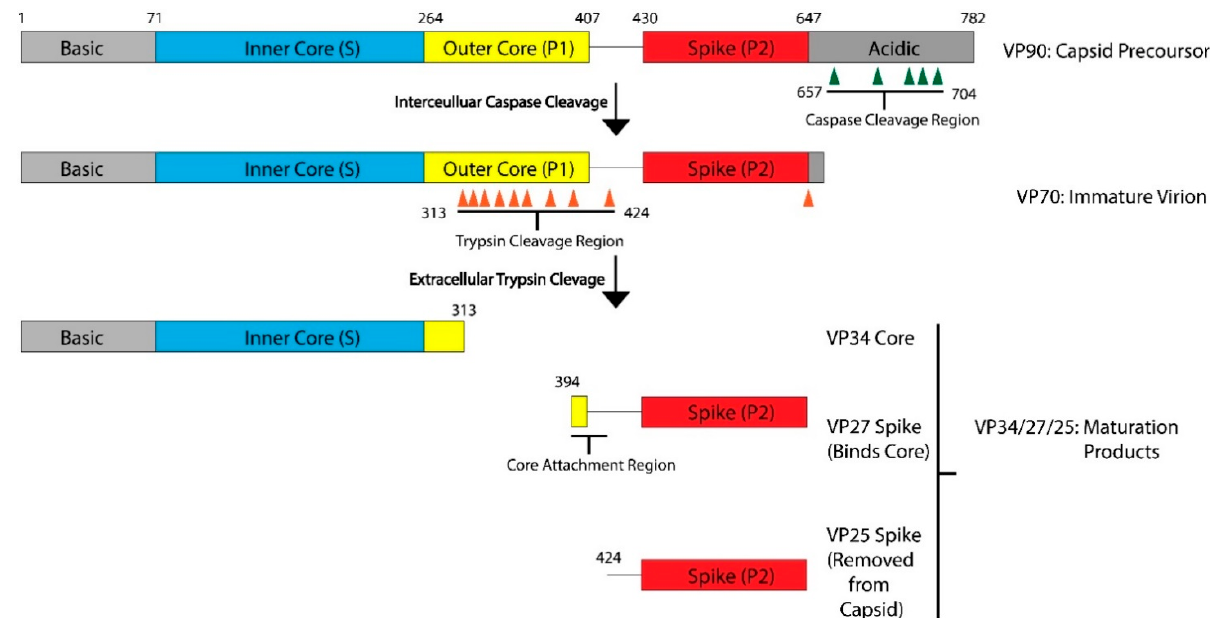
Figure 1. Maturation Process Modeled with HAstV ‐ 8. After translation, the viral capsid protein forms the VP90 precursor. The acidic domain is cleaved by caspases along sites in the acidic domain, resulting in the VP70 immature virion. This VP70 virion exits the cell, where it is exposed to extracellular proteases. There are multiple trypsin cleavage sites in the P1 outer core domain, leading to the generation of the VP34 core, VP27 spike, and VP25 spike domains. These three products, and possibly some of the digested peptides from the outer core domain, assemble into the VP34/27/25 mature capsid. VP27 can form a homodimer and associate with the VP34 core domain. VP25, which has the core attachment region cleaved, is not present in the mature particle. Domains and regions are numbered according to the sequence of HAstV ‐ 8, but the domain architecture and many of the protease cleavage sites are conserved across HAstV ‐ 1 to 8 serotypes. Adapted from [16,17].